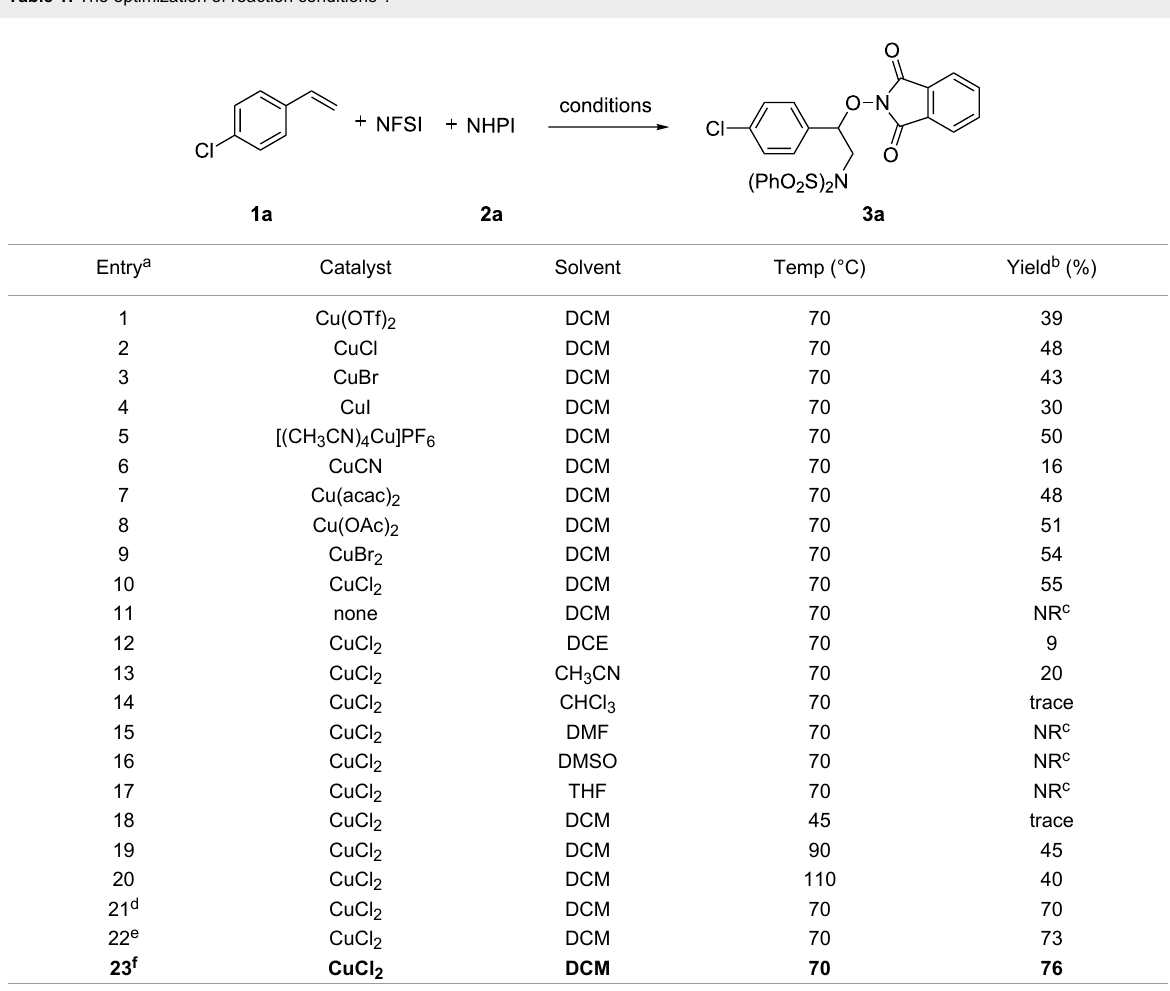
Table 1: The optimization of reaction conditions a